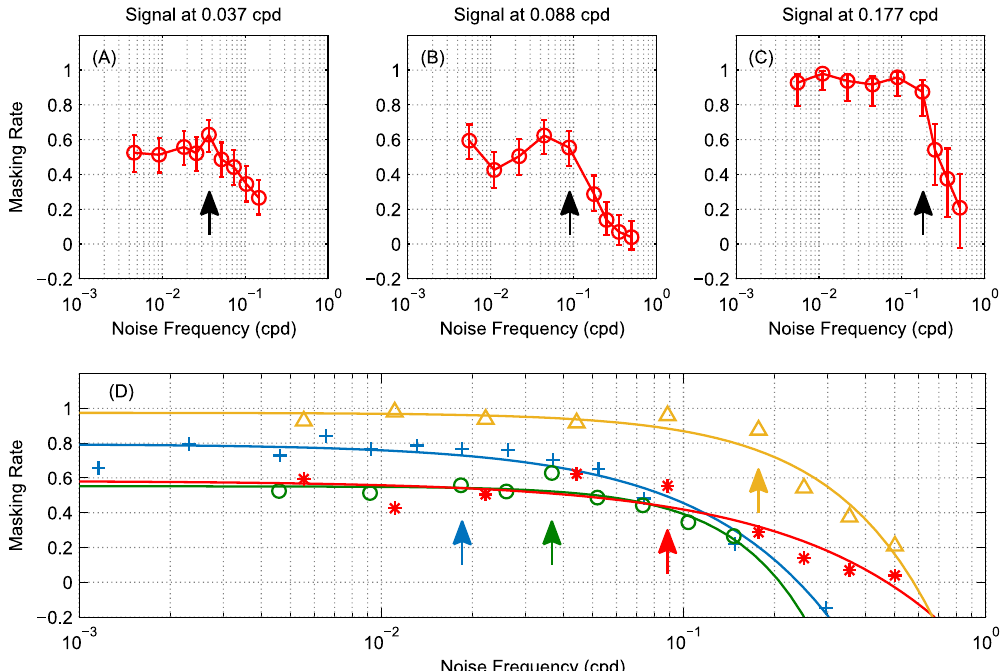
Figure 6. Mantis masking rate measurements at different signal frequencies. ( A – C ) Measurements of masking rate versus noise frequency in the mantis (for signal frequencies 0.037, 0.088 and 0.177 cpd) showing the same masking trends as Figure 5A (signal frequency 0.0185 cpd): noise continues to mask the signal significantly even if its frequency is below the spatial sensitivity passband of mantis motion detectors (~0.01 to 0.1 cpd). Circles are masking rate M defined as M = ( R 0 − R )/ R 0 where R is the response rate (proportion of trials in which mantids responded optomotorally in the same direction as the signal grating) and R 0 is the baseline (no-noise) response rate. Error bars are 95% confidence intervals calculated using simple binomial statistics. Signal frequency is marked on each plot by an arrow. ( D ) Masking rate fits for the four signal frequencies combined, demonstrating a masking effect that is qualitatively different from humans (cf. Figure 3). Fitted functions are in the form = − . − M f ) . Arrows indicate signal frequencies. Data-points are replotted from panels (A–C) and from Figure